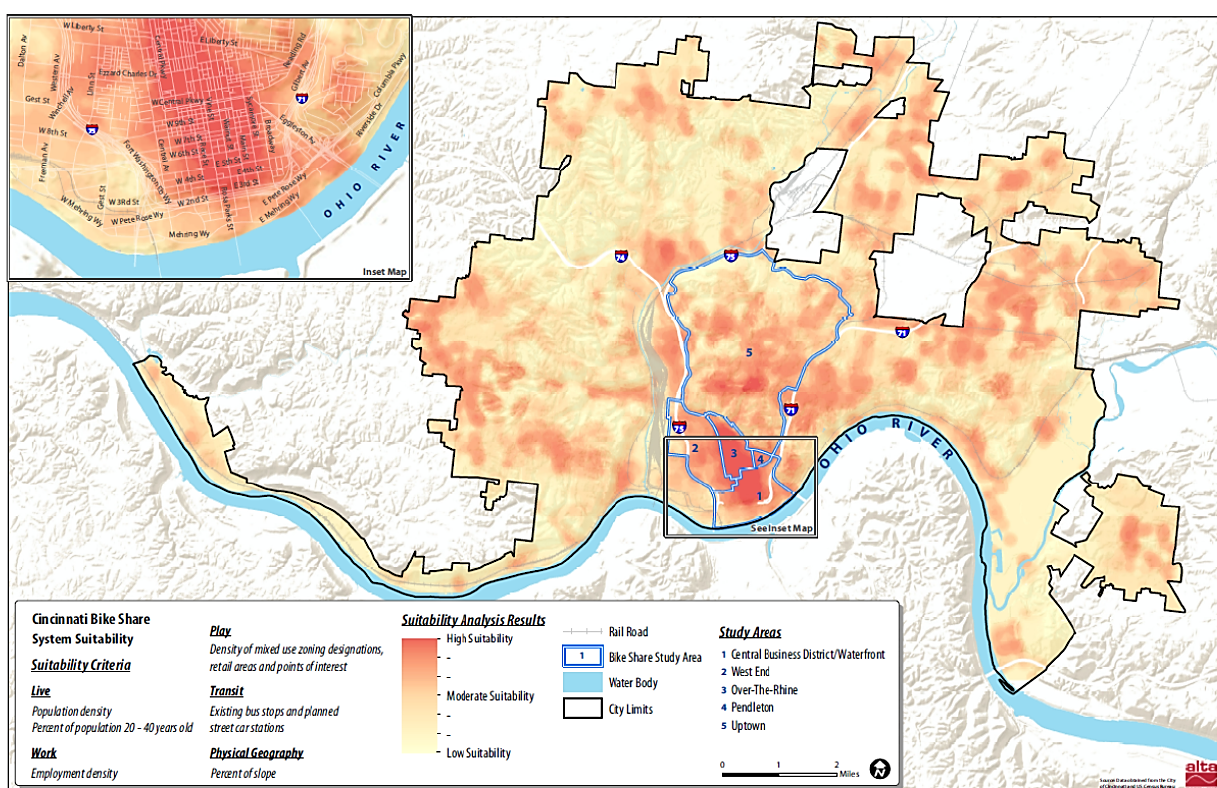
Figure 2. Suitability analysis for Cincinnati Bike-Share Feasibility Study (Alta Planning + Design, 2012, p.